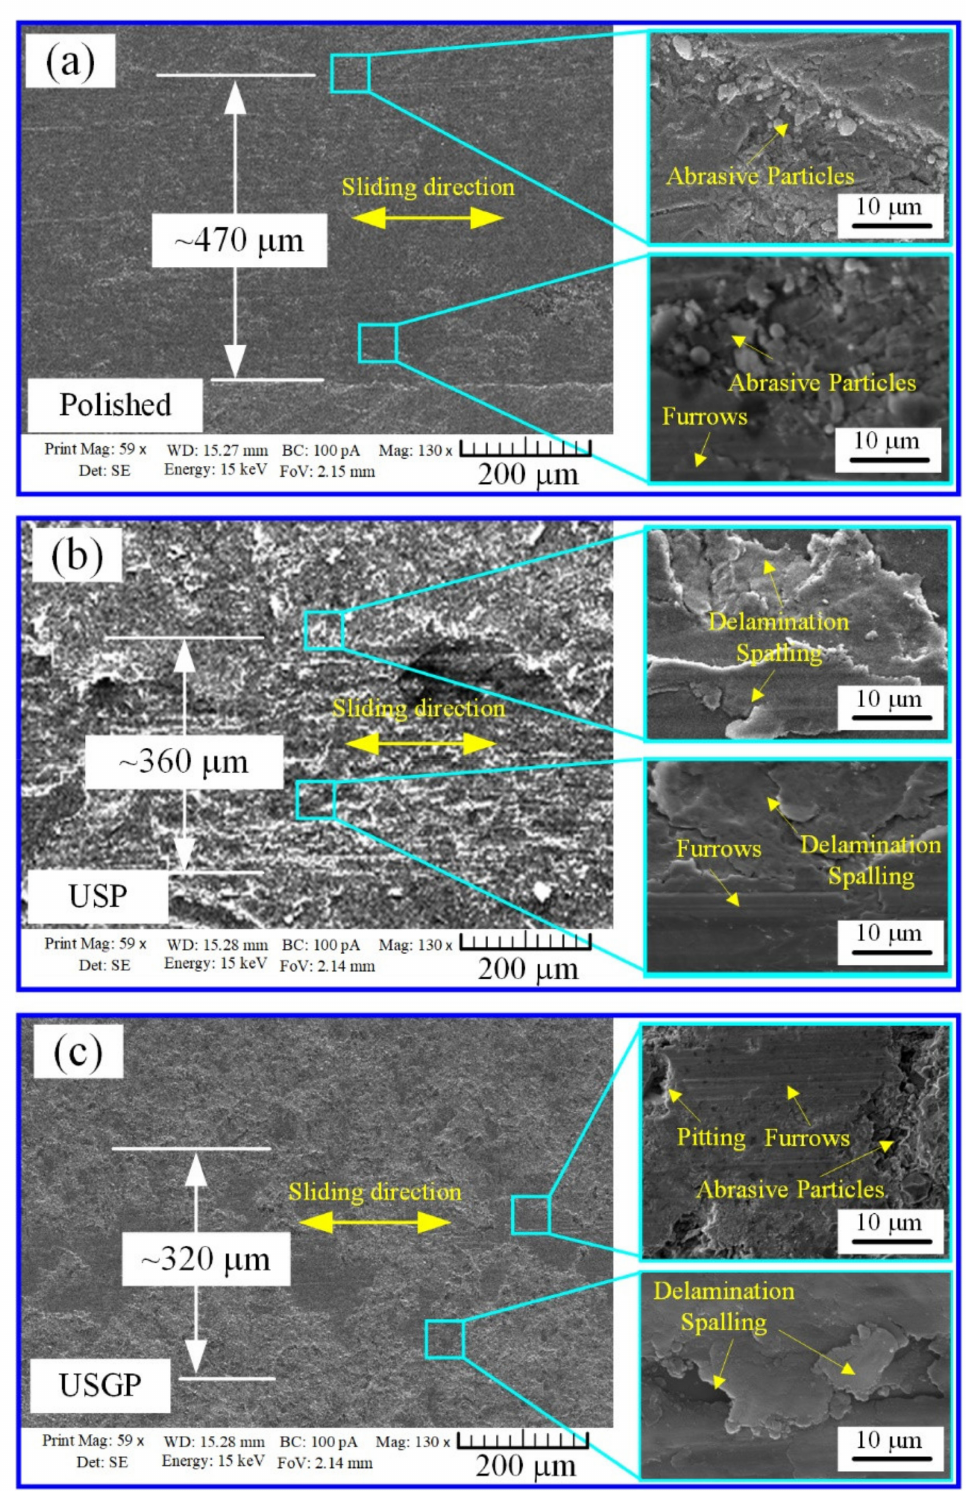
Figure 14. SEM images that were taken in the middle of the wear track for polished ( a ), USP ( b ), and USGP samples ( c ) after sliding for 600